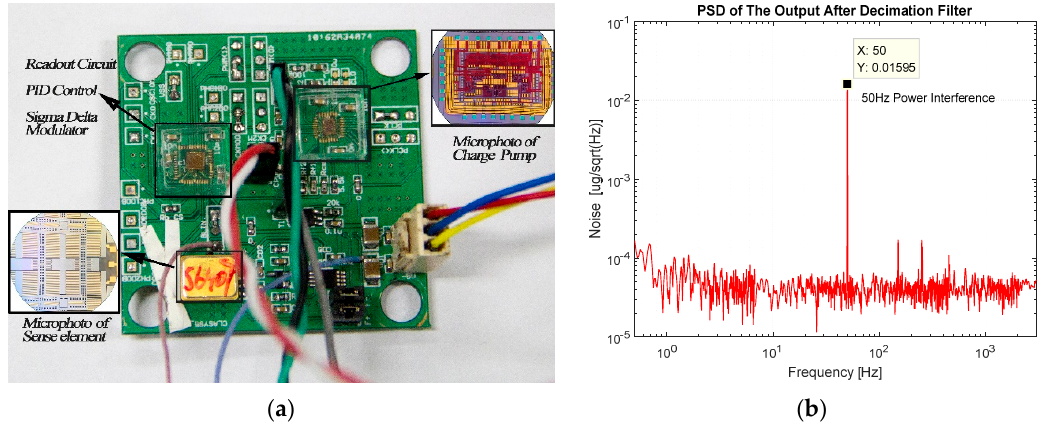
Figure 8. The MEMS accelerometer: ( a ) The laboratory prototype of MEMS accelerometer using charge pump; ( b ) PSD of the accelerometer’s output after decimation filter.